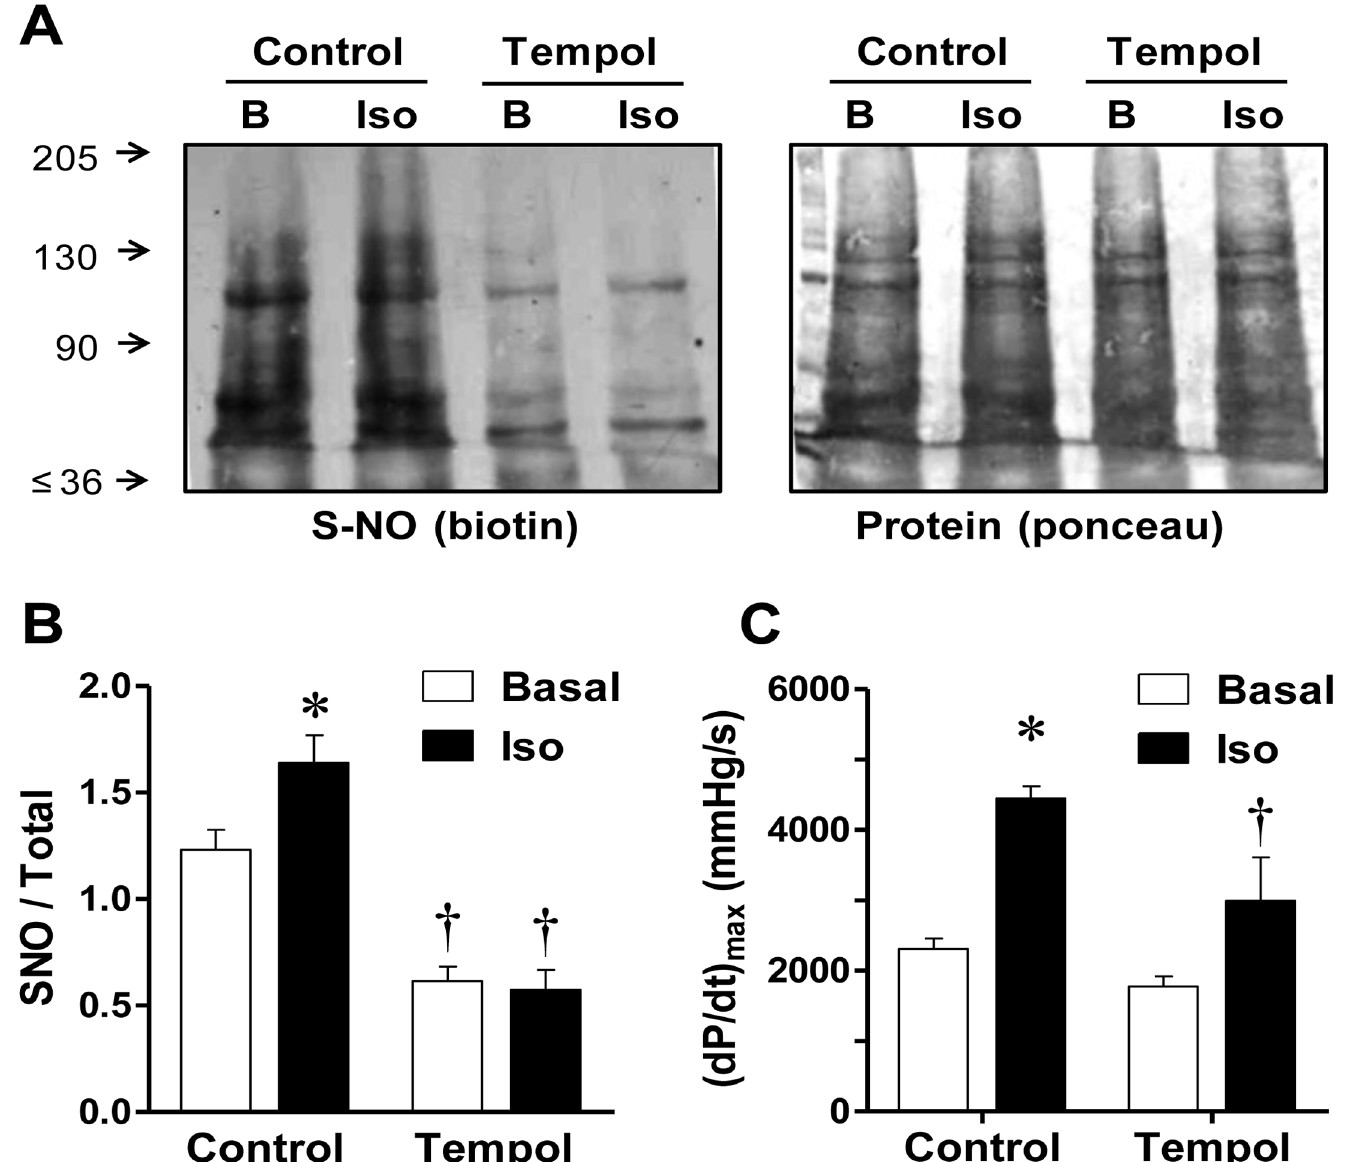
Fig 8. Tempol reduces protein S-nitrosylation and cardiac contractility. (A) Representative Western blots showing protein S-nitrosylation in hearts homogenized prior (basal, B), or after stimulation with isoproterenol (10nM, 3-min, Iso), in control conditions or after 20-min treatment with tempol (100 μ M). Homogenized tissue was submitted to the biotin-switch assay and SDS-PAGE. The same membrane is shown stained for biotin (left) and for total protein (right), as detailed in the legend to Fig 3. (B) Densitometric analysis of the normalized biotin/total protein signal for 8 similar experiments. Two-way ANOVA indicated significant effect of tempol (p < 0.0001) and interaction (p < 0.05). (C) Cardiac contractility determined in the same hearts immediately previous to homogenization. Two-way ANOVA indicated significant effect of tempol (p < 0.01), and isoproterenol (p < 0.001) without significant interaction. * p < 0.05, ** p < 0.01 vs. respective Basal; † , p < 0.01 vs. corresponding Control